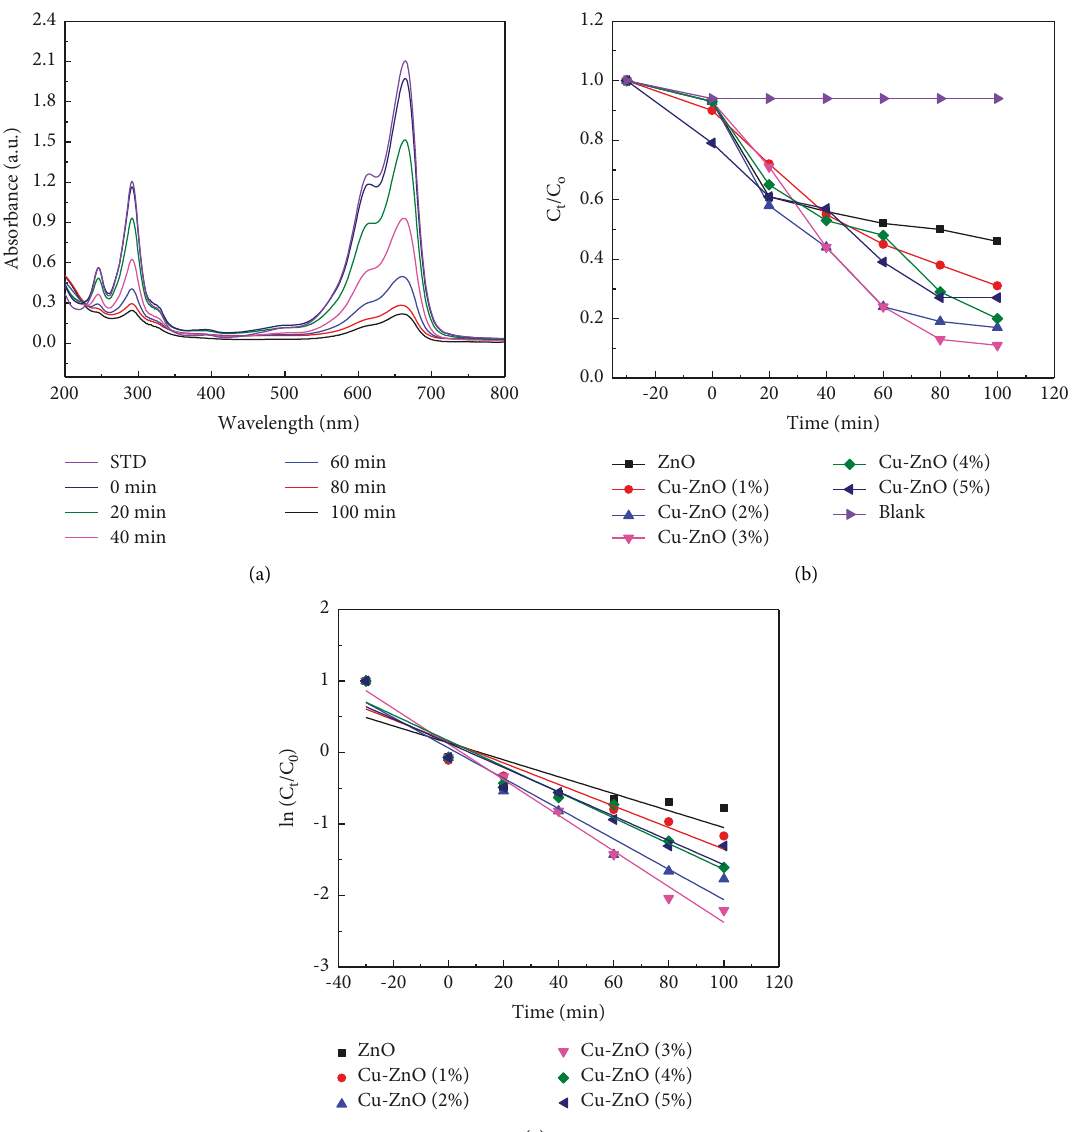
Figure 7: (a) UV-vis absorption spectra of Cu-ZnO (3%) and (b) C ZnO (2%), Cu-ZnO (4%), and Cu-ZnO (5%) catalysts.